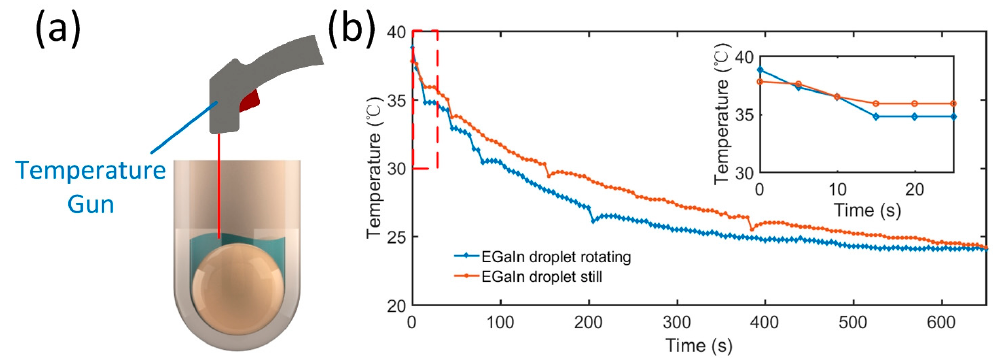
Figure 3. Cooling system based on a self-rotating LMD. ( a ) Schematic illustration of the cooling setup. ( b ) Temperature of solution vs. time plot.